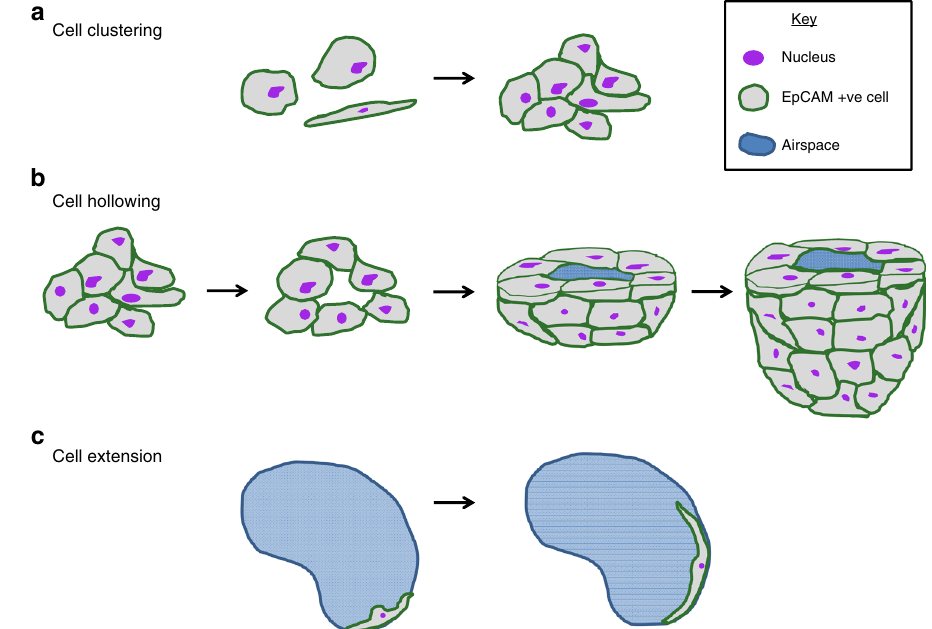
Fig. 9 Diagram depicting cell behaviours identi fi ed in time-lapse videos. Schematic to show migratory epithelial behaviours that contribute to different stages of alveolar development. a Epithelial cells migrate and form clusters; b a small hole forms within a cell cluster, this widens and deepens to form a hollow following which additional epithelial cells migrate and integrate into the alveolus (g); c a cell extends around the wall of a mature